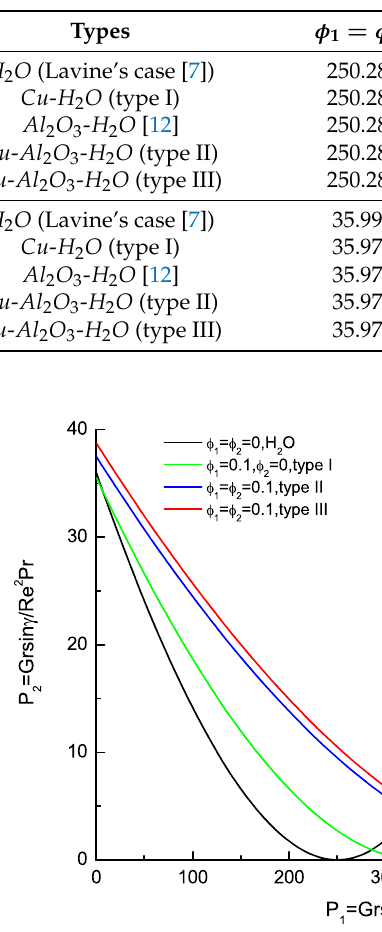
Table 5. The critical values of P 1 and P 2 .